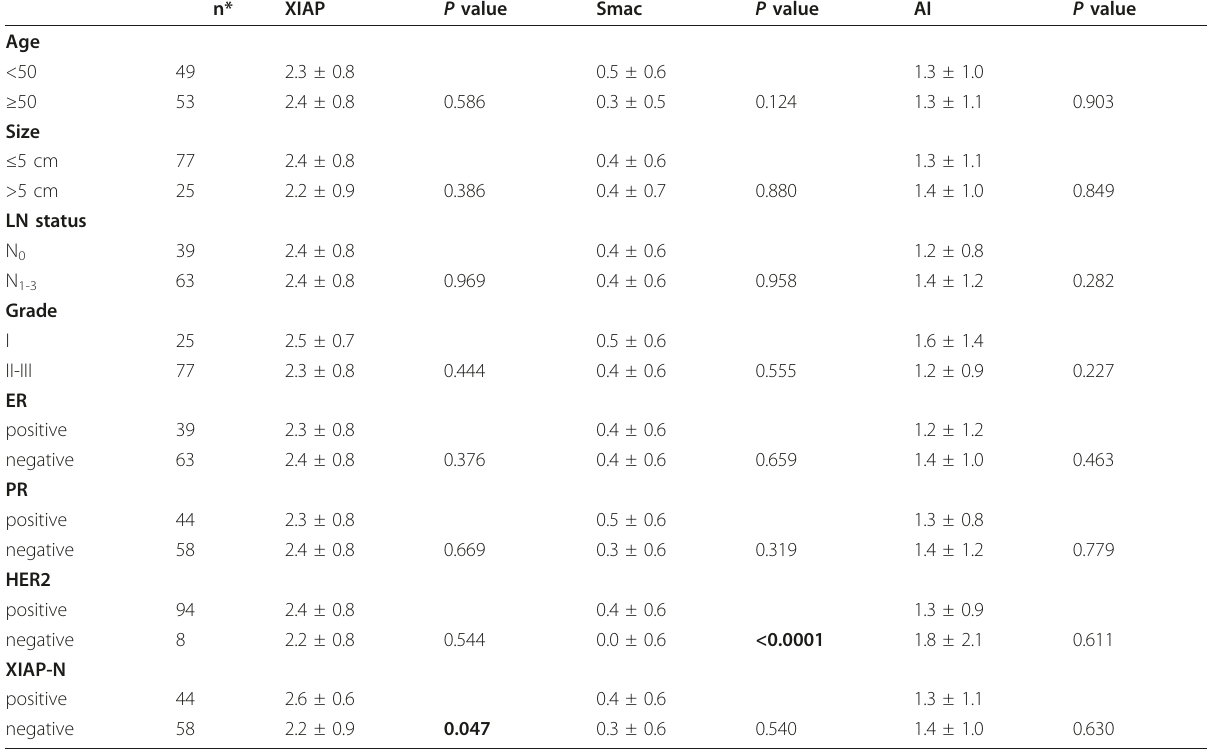
Table 3 Relationship analysis among XIAP/Smac immunoscore, apoptosis index, and clinicopathologic